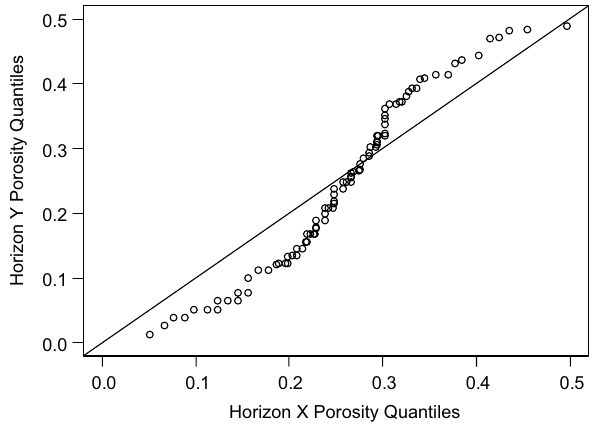
Fig. 13 Q–Q plot of Horizon X quantiles plotted against Horizon Y